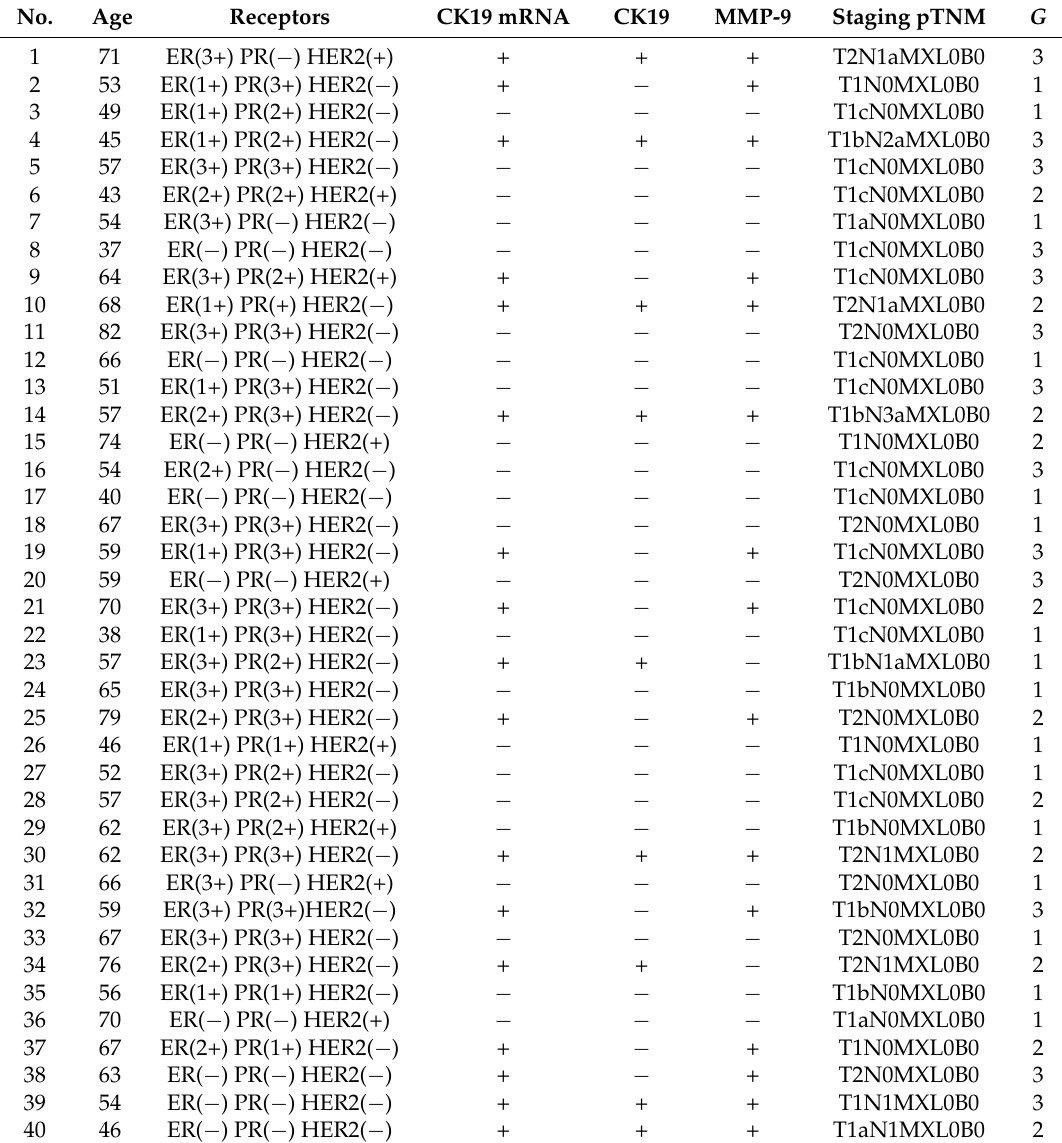
Table 1. Clinico-pathological characteristics of 40 patients with breast carcinoma of no special type, and relevant immunohistochemical and CK19 mRNA data. In each of 40 cancer cases only one lymph node has been examined. CK19 mRNA (OSNA), CK19, and MMP-9 (IHC) were evaluated in SLNs, whereas receptors in primary tumors. HER2 (+)—means 3+ or 2+ and after FISH verified as 3+ (positive); N0—no macrometastasis has been found; N1-3—macrometastasis in lymph node has been found; pTNM—established before OSNA analysis; L (LV)—lymphatic vessels embolism; B (BV)—blood